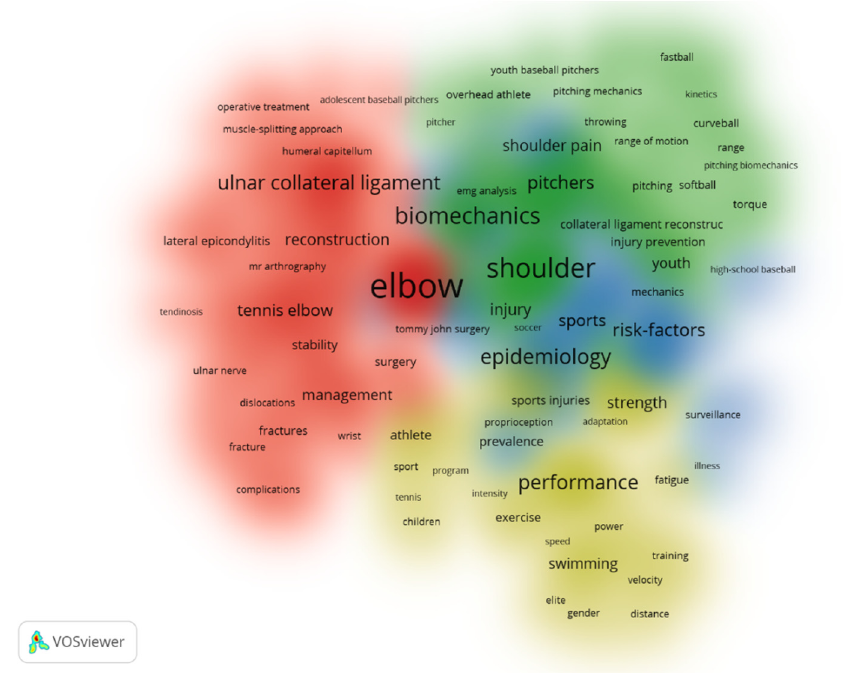
Figure 4. Analysis of the keywords in publications on elbow pain: density visualization. 174 key- words that occurred more than 5 times were enrolled. The font size represents the frequency of occurrence.